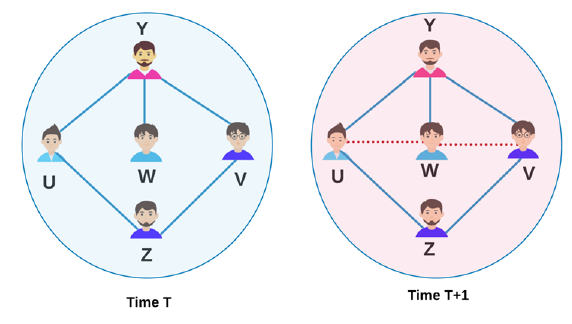
Figure 1. Example of Link